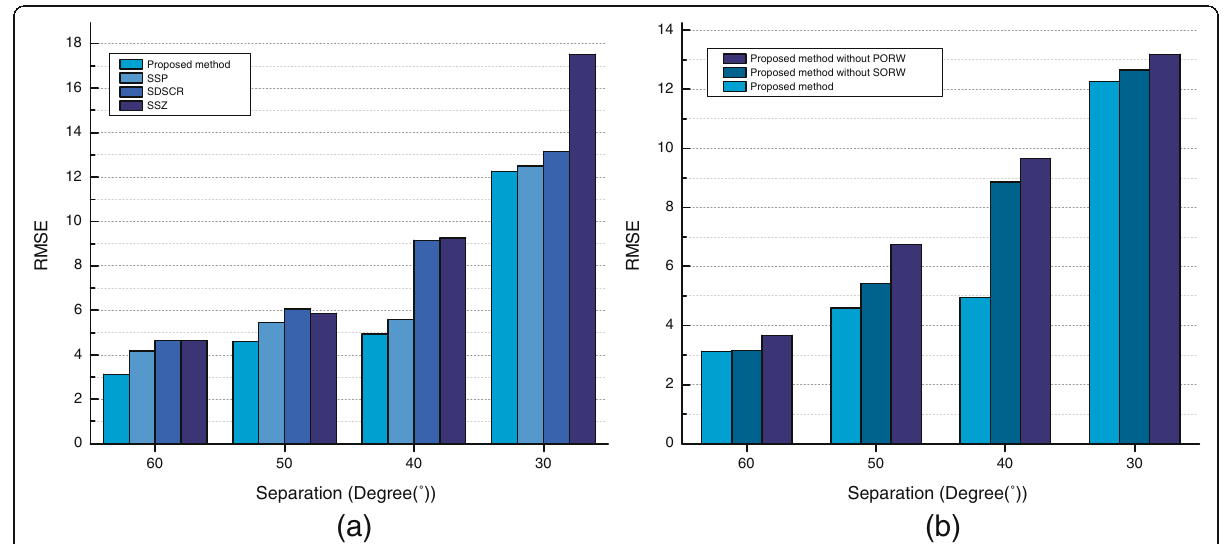
Fig. 10 RMSE of localization results with different separation among sources, three sources, RT60 = 150 ms. a The RMSE of localization results using different methods. b The RMSE of localization results using different proposed